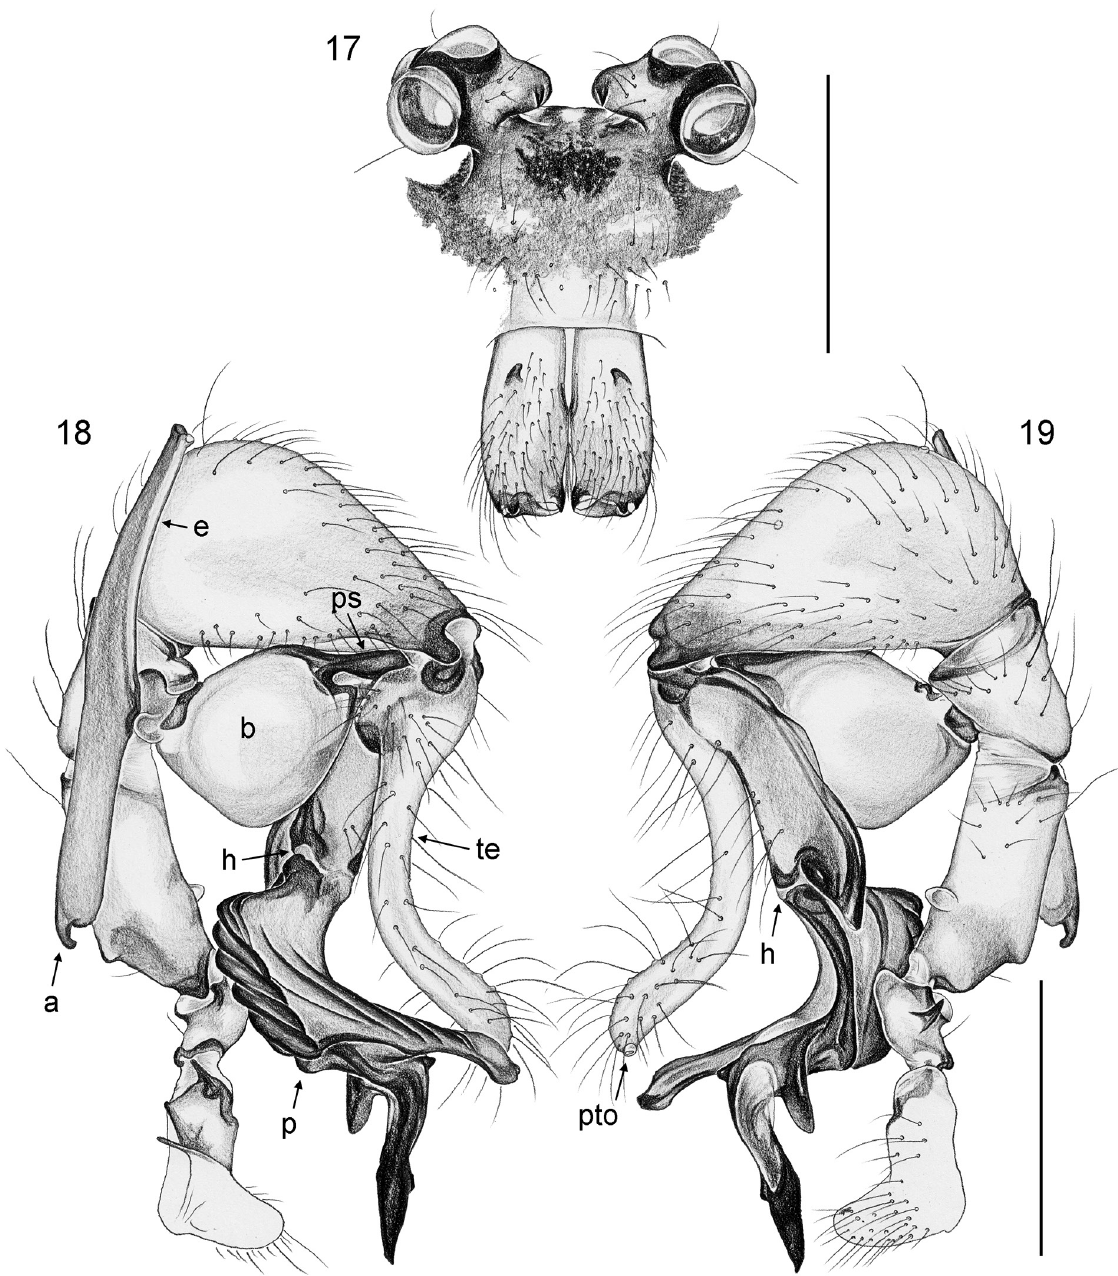
Figs 17–19. Panjange malagos Huber sp. nov. (ZFMK, Ar 12999). 17 . Male prosoma and chelicerae, frontal view. 18–19 . Left male palp, prolateral and retrolateral views. Abbreviations: a = appendix; b = genital bulb; e = embolus; h = hinge; p = procursus; ps = proximal bulbal sclerite; pto = palpal tarsal organ; te = tarsal elongation. Scale bars = 0.5